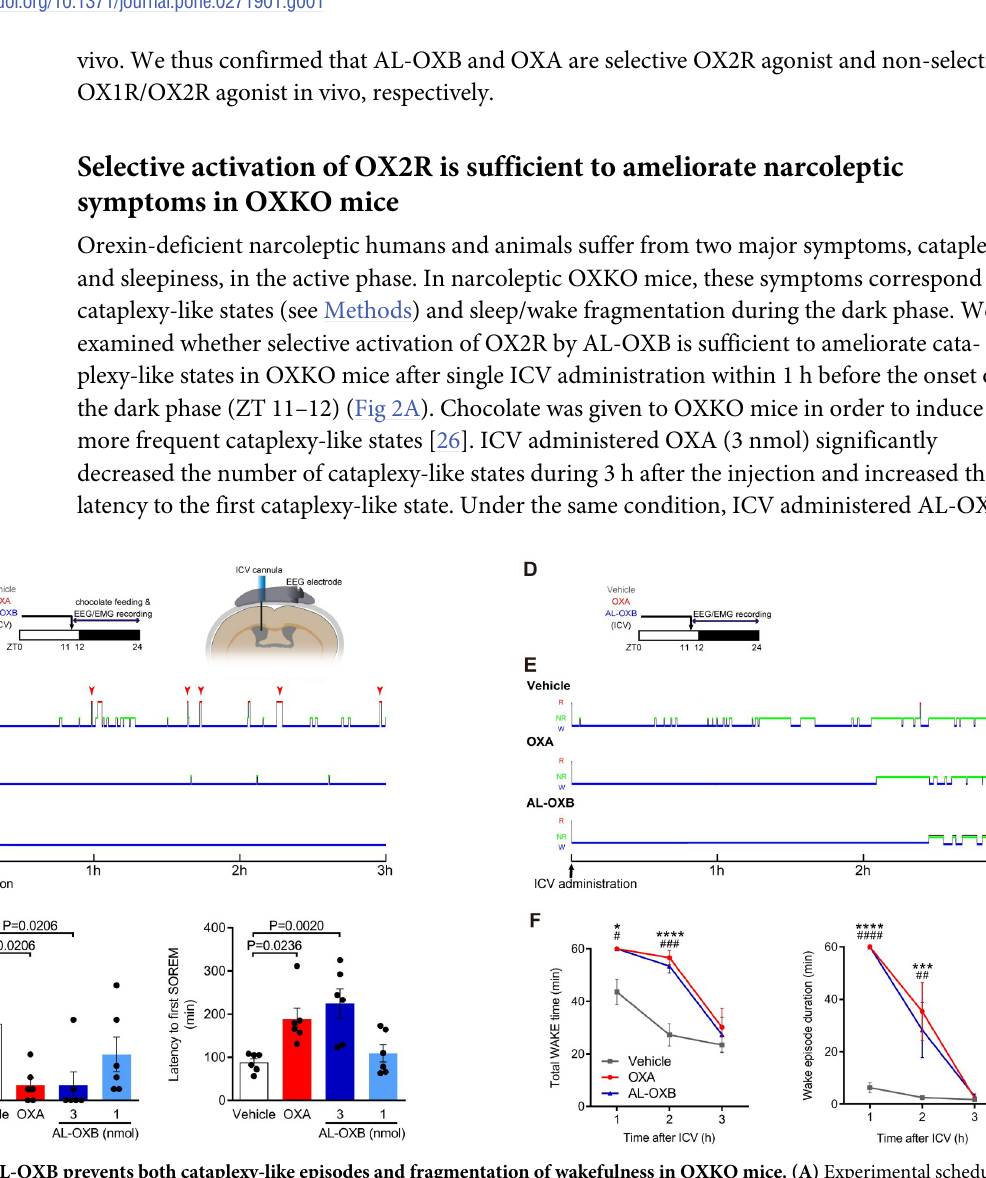
Fig 1. [Ala 11 , D -Leu 15 ]-orexin-B (AL-OXB) selectively activates OX2R in vitro and in vivo. (A) Dose-response curves of intracellular Ca 2+ transients induced by OXA and AL-OXB in CHO/OX1R cells (left) and CHO/OX2R cells (right). Data represent the mean ± SEM from two independent assays. (B) Representative images of c-fos immunoreactivity (green) after ICV administration of OXA or AL-OXB in tyrosine hydroxylase-positive (red) noradrenalin neurons of the LC and histidine decarboxylase-positive (red) histamine neurons of the TMN. 4V: 4th ventricle. Regions marked by white rectangles are magnified in small panels. Scale bars: small panels, 25 μ m; large panels, 100 μ m. (C) Quantification of c-fos-positive cells in LC-noradrenergic neurons (left) and TMN-histaminergic neurons (right). Data represent the means ± SEM from 4–5 mice. Statistical analysis: one-way ANOVA followed by Bonferroni’s multiple comparisons test.